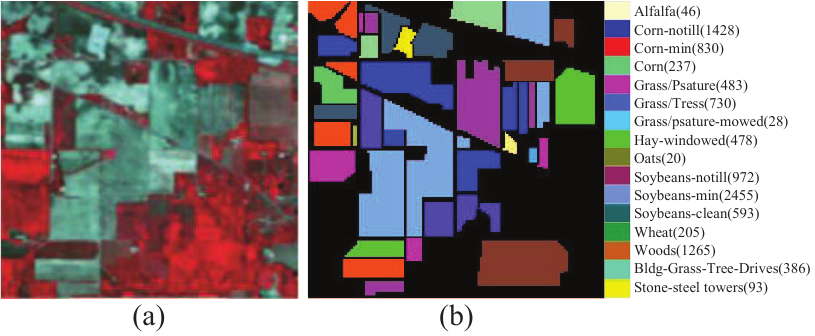
Figure 5. Indian Pines hyperspectral image. ( a ) False-color image. ( b ) Ground-truth map. Salinas dataset [59]: The second dataset was captured in Salinas Valley, Southern California through the AVIRIS sensor. The set is composed of 224 spectral channels after the 20 bands were removed due to the noise and water absorption. The spatial size of this dataset is up to 512 × 217 pixels, and its geometric resolution is 3.7 m. There are sixteen land cover types and the ground truth with corresponding classes are displayed in Figure